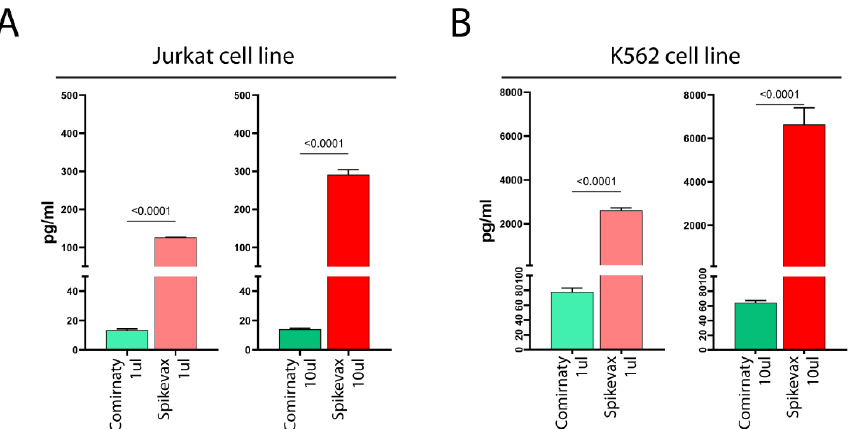
Figure 2. ELISA SARS-CoV-2 Spike protein detection following treatment of cell lines with mRNA- based COVID-19 vaccines. Panel ( A ) (Jurkat cell line) and panel ( B ) (K562 cell line) show the amount (pg/mL) of free S-protein in the supernatant of 1 µL (left) and 10 µL (right) Comirnaty-treated and Spikevax-treated cells, respectively. The mean ± SD is shown in the column bar graphs. Significant differences in S-protein detection between Comirnaty- and Spikevax-treated samples were assessed using the unpaired t -test and p -values are shown.